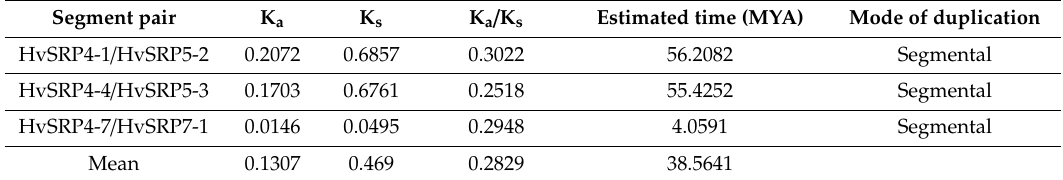
Table 5. The K a and K s values and estimated divergence time for segmentally duplicated HvSRP genes. Segment pair K a K s K a / K